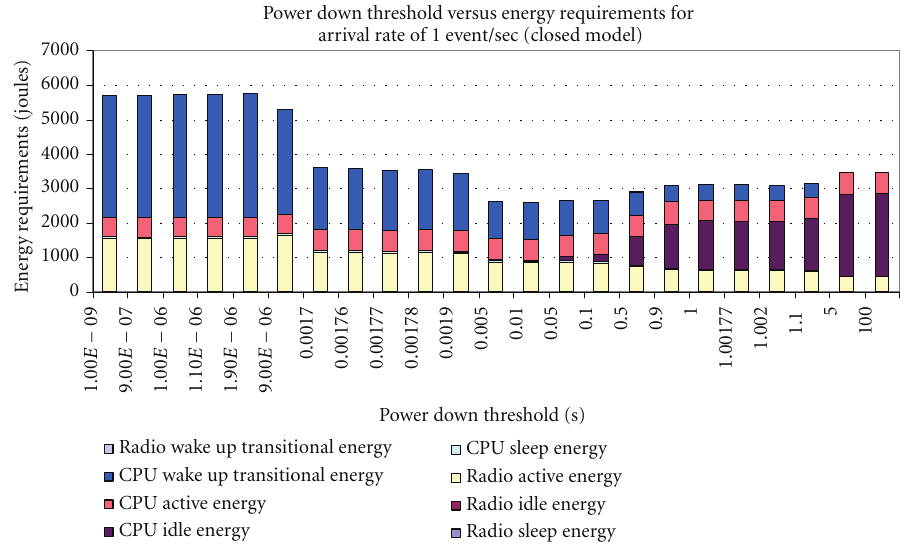
Figure 20: Power Down Threshold versus energy requirements of an open model for an arrival rate of 1 event/second.